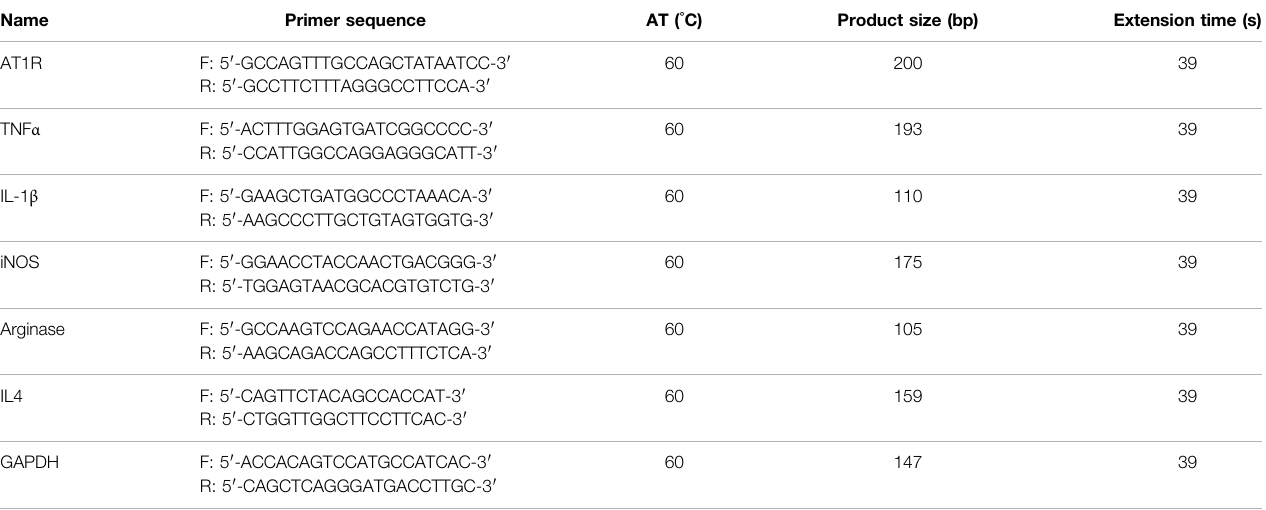
TABLE 1 | Primer sequences (THP-1